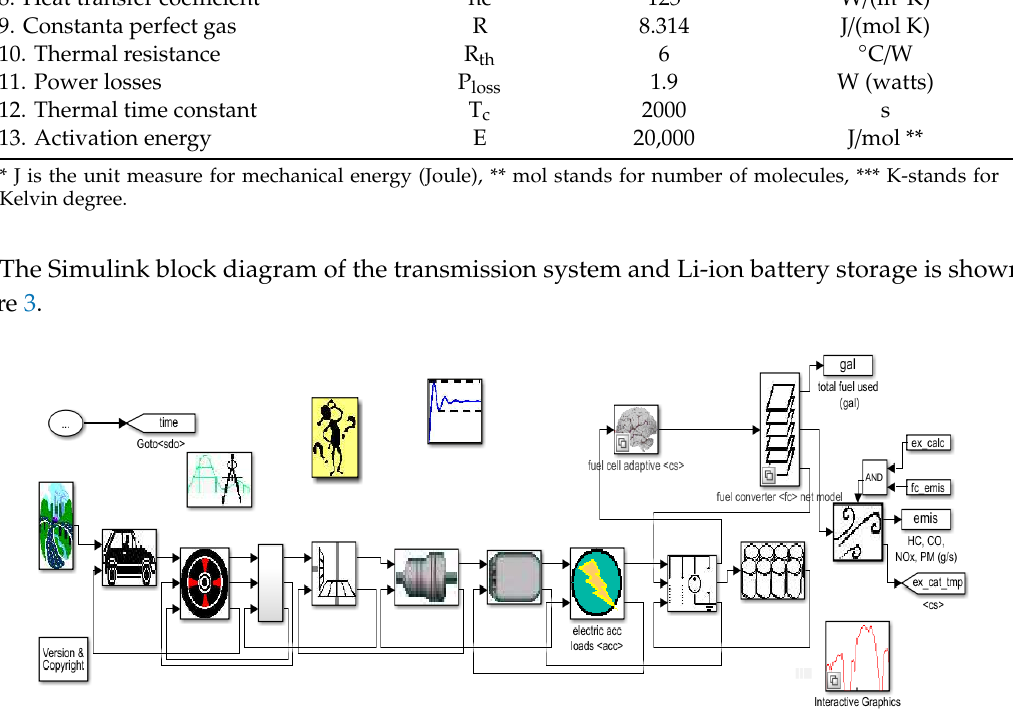
Figure 3. Simulink diagram of the small hybrid electric vehicle (HEV SMCAR) transmission